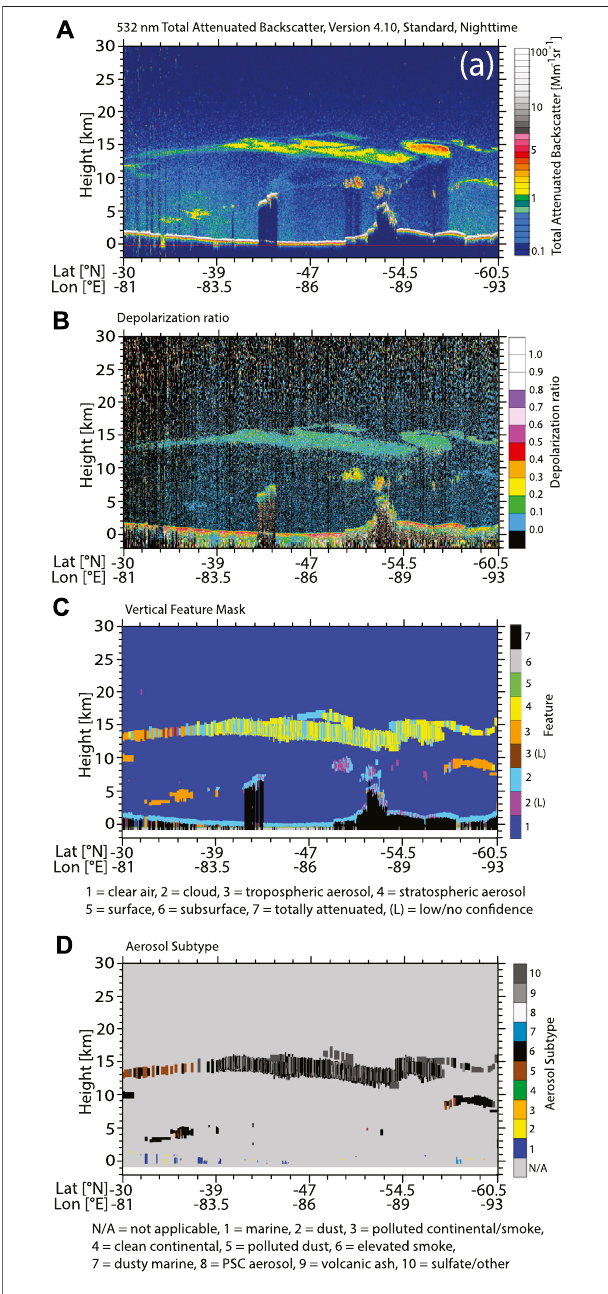
FIGURE 11 | Same as Figures 2 , 5 , except for a CALIOP observation over the Paci fi c Ocean 500 – 1,000 km west of southern South America